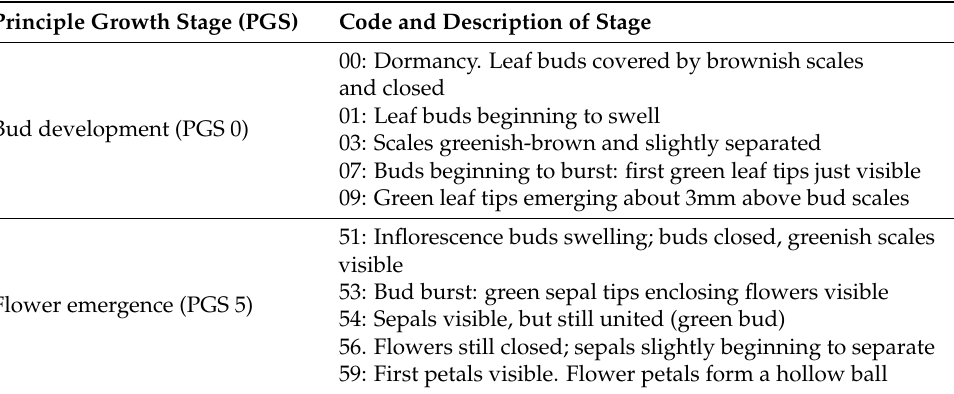
Table 1. Principle phenological codes for bud, flower and fruit development for nashi according to the BBCH scale, as identified by Martinez-Nicol á s et al.